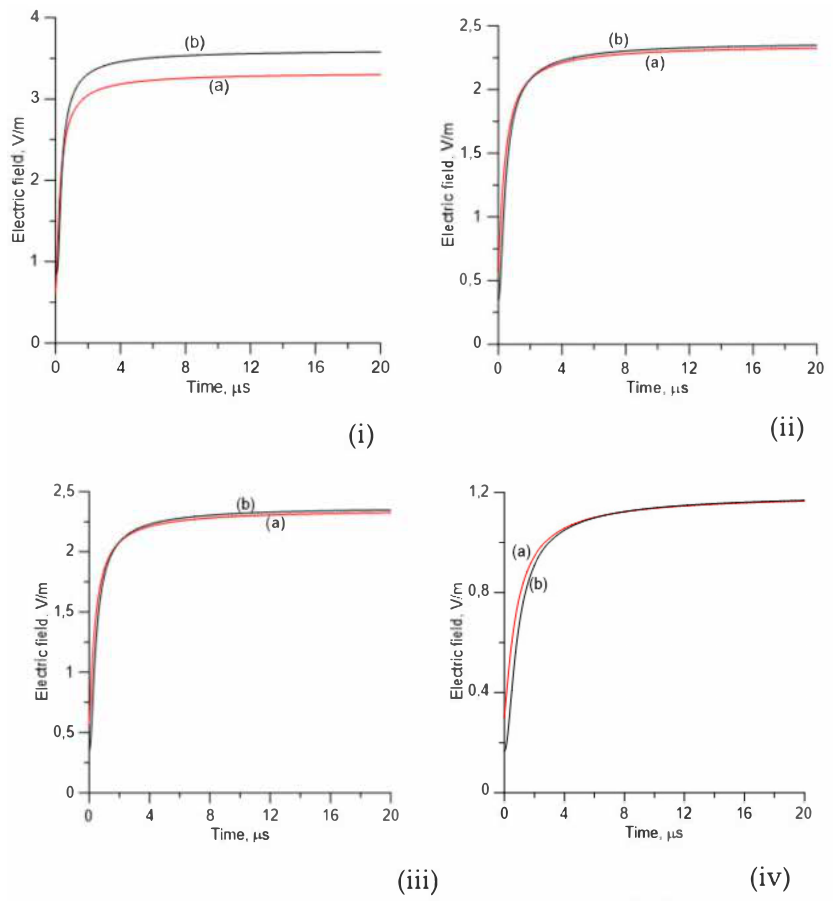
Figure 2. Vertical electric field at the point of observation when the return stroke current is a step function. ( i ) d = 30 m, ζ = 20 m; ( ii ) d = 50 m, ζ = 10 m; ( iii ) d = 50 m, ζ = 20 m; ( iv ) d = 100 m, ζ = 10 m. The speed of propagation of the pulse is 1.5 × 10 8 m/s. Curve marked (a) in red represents the exact and (b) in black represents the Rusck approximation.